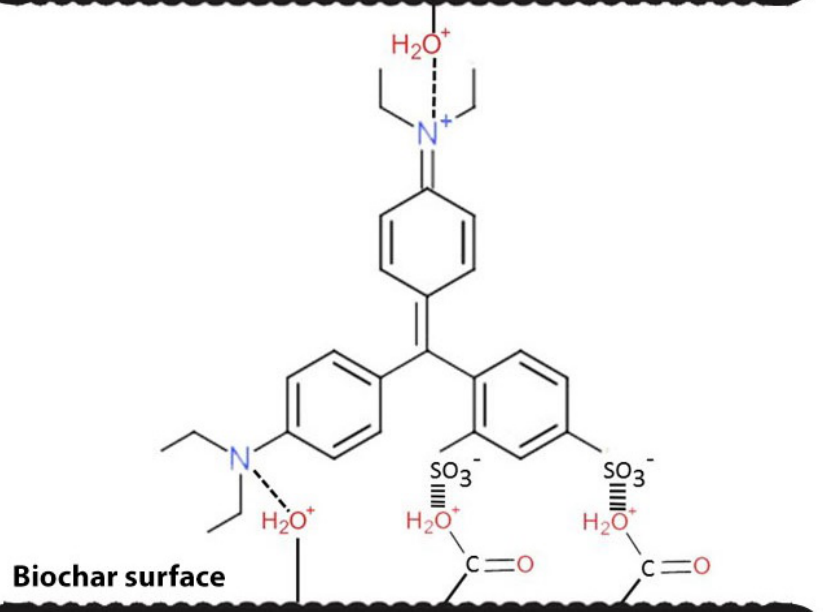
Figure 4. Proposed mechanism of Patent Blue V dye adsorption onto Sterculia alata fruit shell biochar (adapted from Roy et al. [17]).